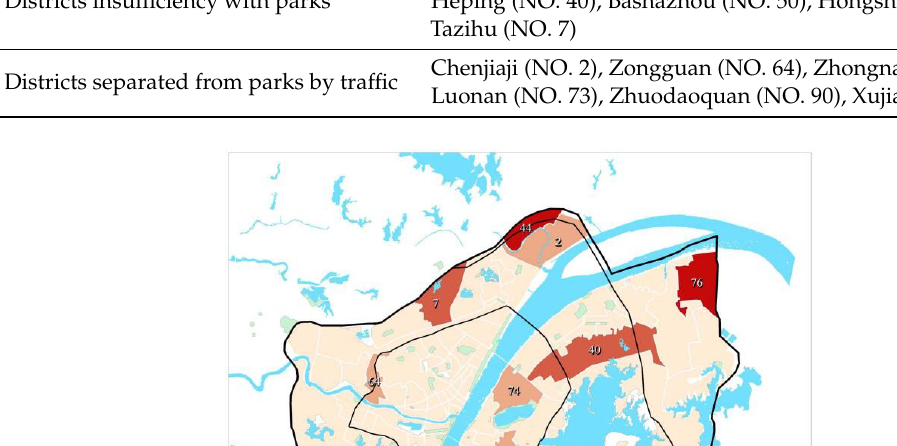
Table 5. Typical district classification.